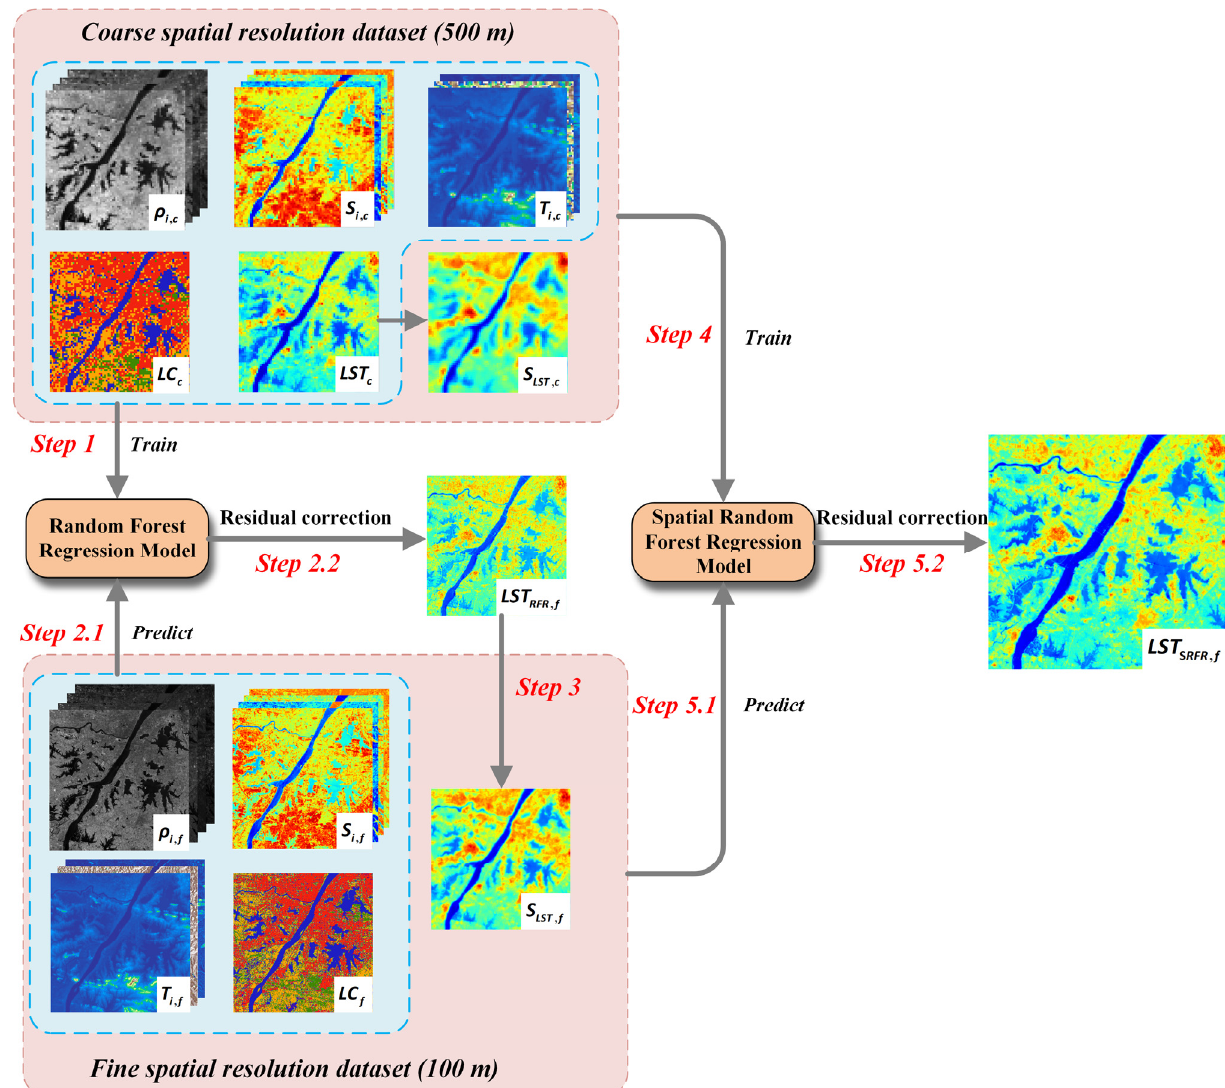
Figure 2. Flowchart of the spatial random forest downscaling method (SRFD).